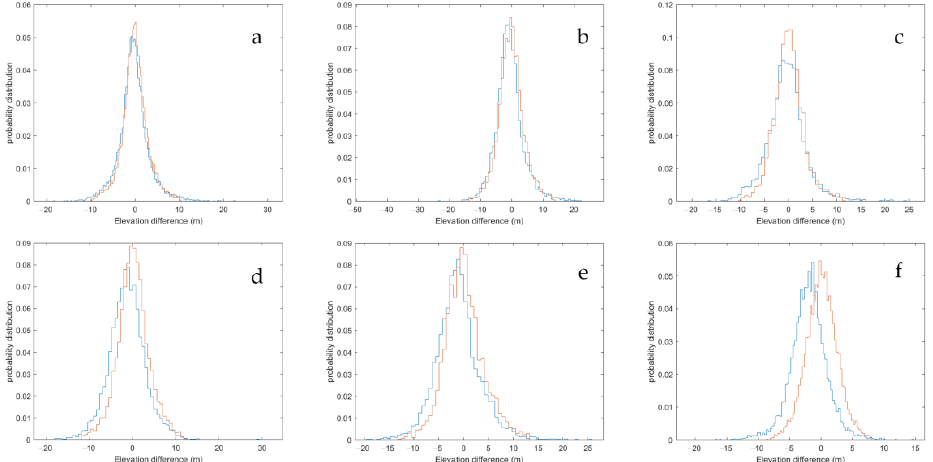
Figure 8. Probability density distribution of elevation difference before and after registration and correction. Blue represents the distribution prior to registration and correction, and red indicates the distribution after registration and correction. ( a – f ) represent Gangnalou Glacier, Laohugou No. 12 Glacier, Dunde Ice Cap, the 93.5 ◦ E 39.2 ◦ N Glacier, Shiyang River, Bayi, Suzhulian Glacier Group and the 97.2 ◦ E 38.7 ◦ N Glacier,